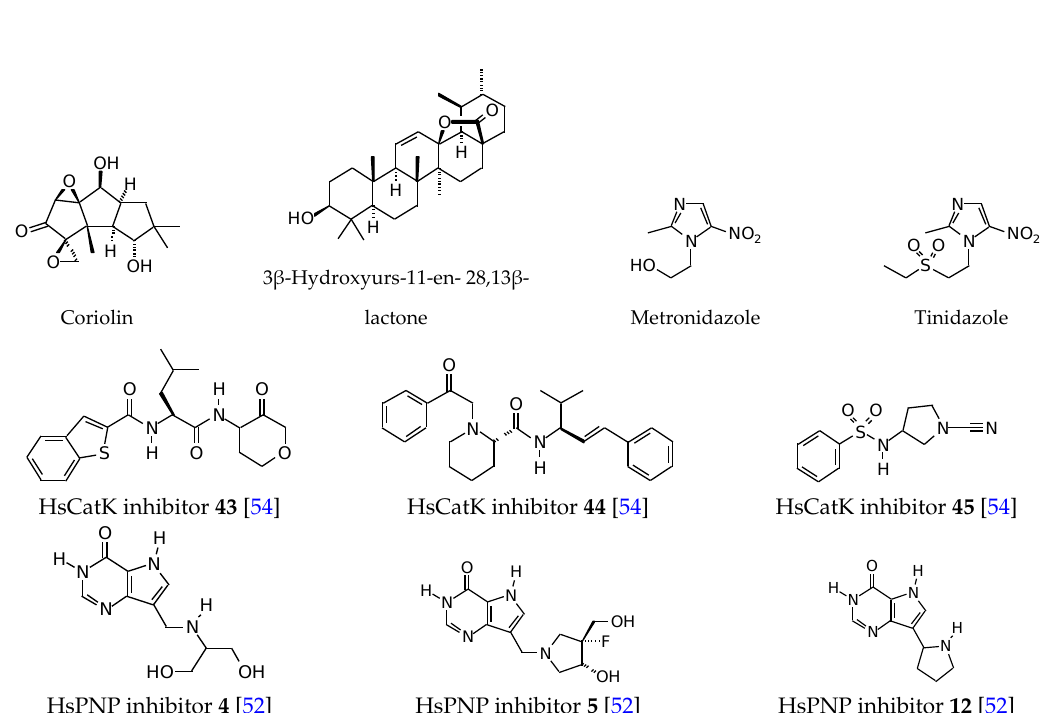
Figure 9. Phytochemical ligands that showed promising docking properties with Trichomonas vaginalis target proteins, as well as known T. vaginalis inhibitors and synthetic inhibitors. There were several antiprotozoal phytochemicals that showed potential as T. vaginalis methionine gamma-lyase inhibitors with docking scores < − 125 kJ/mol (Table 5): the aurone 6-benzoyl- 2-[oxomethylpheny]-3-hydroxy-benzofurane (DS norm = − 125.5 kJ/mol); the lignans eupomatenoid-5, eupomatenoid-6, and eupomatenoid-7 (DS norm = − 130.3, − 131.4, and − 134.7 kJ/mol, respectively); the cannabinoids 5-acetyl-4-hydroxycannabigerol (DS norm = − 127.6 kJ/mol) and cannabigerolic acid kJ/mol); and the stilbenoids trans -4-(3-methyl- E -but-1-enyl)- 3,5,2 ′ ,4 ′ - tetrahydroxystilbene (DS norm = − 127.8 kJ/mol) and trans -4-isopentenyl-3,5,2 ′ ,4 ′ - tetrahydroxystilbene